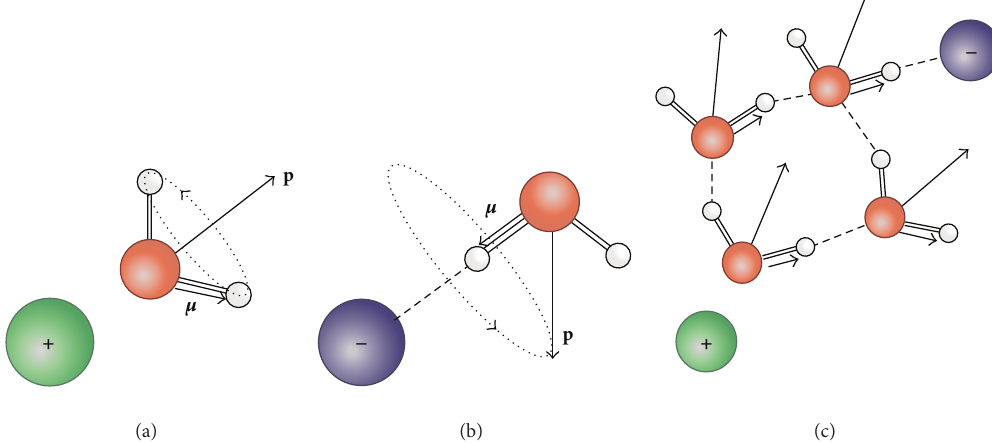
Figure 1: Semirigid hydration and cooperativity ((a) and (b)) a water molecule in the solvation shell of a cation (a) and an anion (b). Dielectric relaxation measurements probe the reorientation of the permanent dipole vector p . Femtosecond infrared spectroscopy is sensitive to the reorientation of the OD-stretch transition dipole moment 𝜇 . The dotted arrows indicate reorientation in a cone, in the case of semirigid hydration. (c) Proposed geometry, in which the water dynamics are locked in two directions because of the cooperative interaction with the cation and the anion. Figure 1 is reproduced here from (Tielrooij et al. 2010) [153] with permission of the American Association for the Advancement of Science.